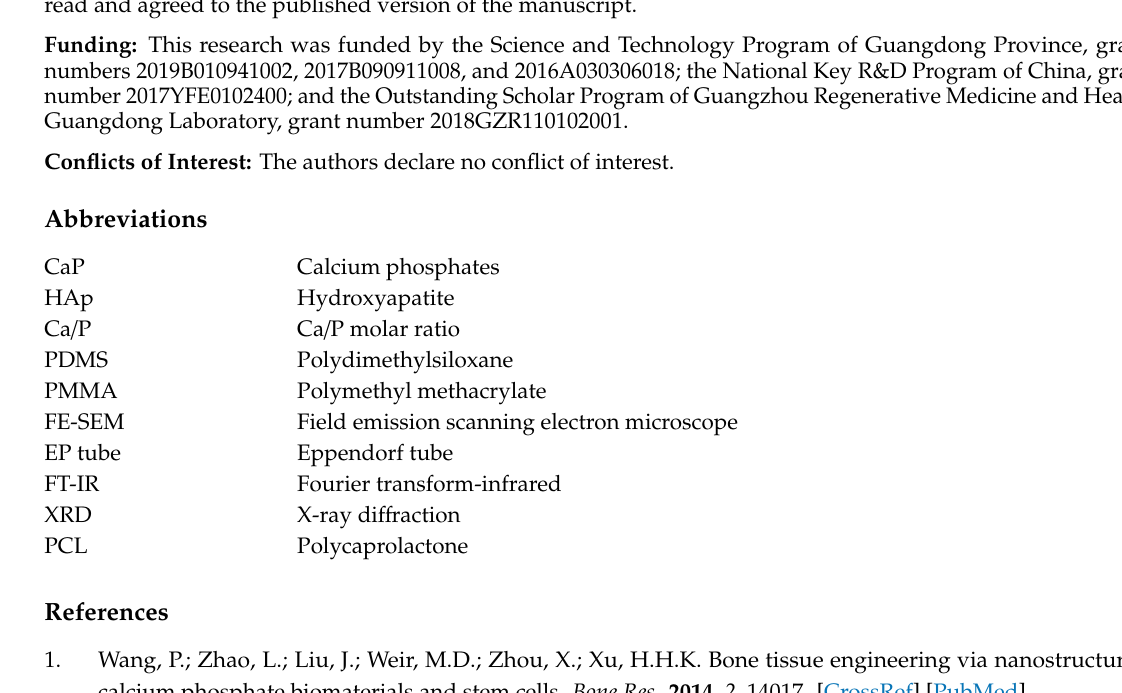
schematic overview of PDMS chip fabrication procedures; Figure S3: photographs of hydrogel block mold and red ink experimental demonstration; Figure S4: SEM images of CaP structures observed at a3 and h3 in the pH gradient screening experiment through the platform; Figure S5: Fourier transform-infrared (FT-IR) spectra (A) and X-ray di ff raction patterns (B) of CaP prepared in the scale-up